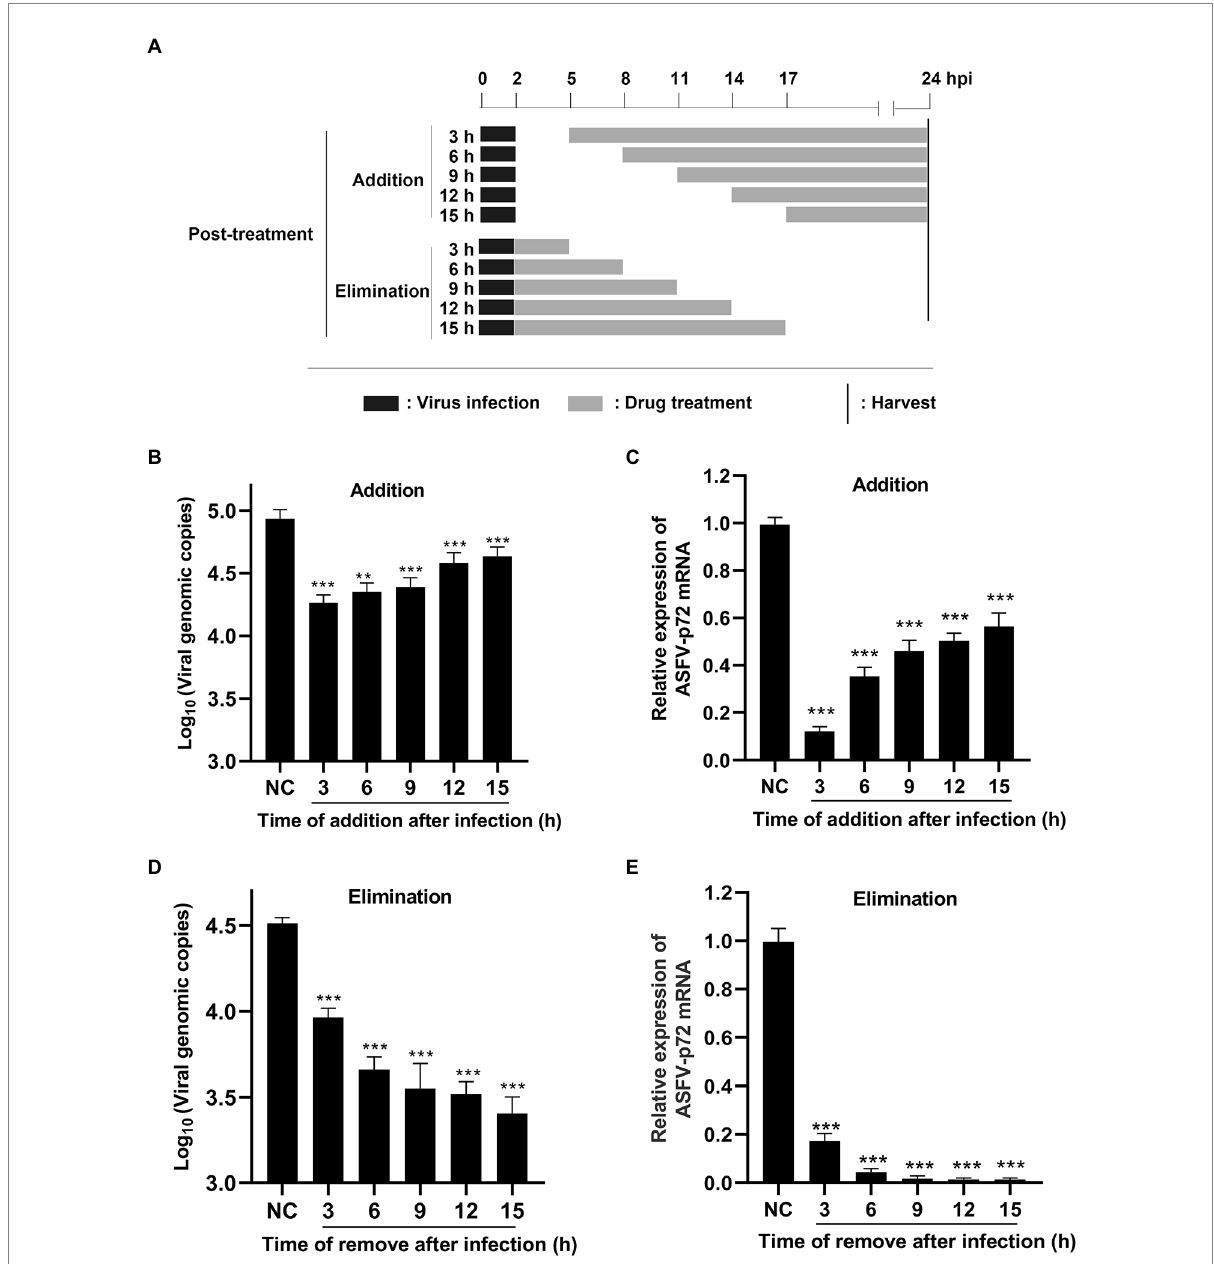
FIGURE 5 Post-treatment of TSN suppresses ASFV replication in PAMs. (A) For the post-treatment experiment, PAMs seeded in 48-well plates were challenged with ASFV (0.014 MOI) for 2 h. 1 μ M TSN was added into the cell at 3, 6, 9, 12, and 15 hpi, respectively; For the elimination experiment, PAMs seeded in 48-well plates were challenged with ASFV (0.014 MOI) for 2 h, and then 1 μ M TSN was added into the cells. TSN was then discarded at 3, 6, 9, 12 and 15 hpi, respectively, and replaced with fresh maintenance medium. All the samples of the two experiments were harvested at 24 hpi for qPCR and RT-qPCR. (B, C) The DNA level of ASFV p72 gene was determined by qPCR (B) and the mRNA level of ASFV p72 gene was determined by RT-qPCR (C) . (D, E) The DNA level of ASFV p72 gene was determined by qPCR (D) and the mRNA level of ASFV p72 was determined by RT-qPCR (E) . *** denotes p < 0.001. NC denotes the negative